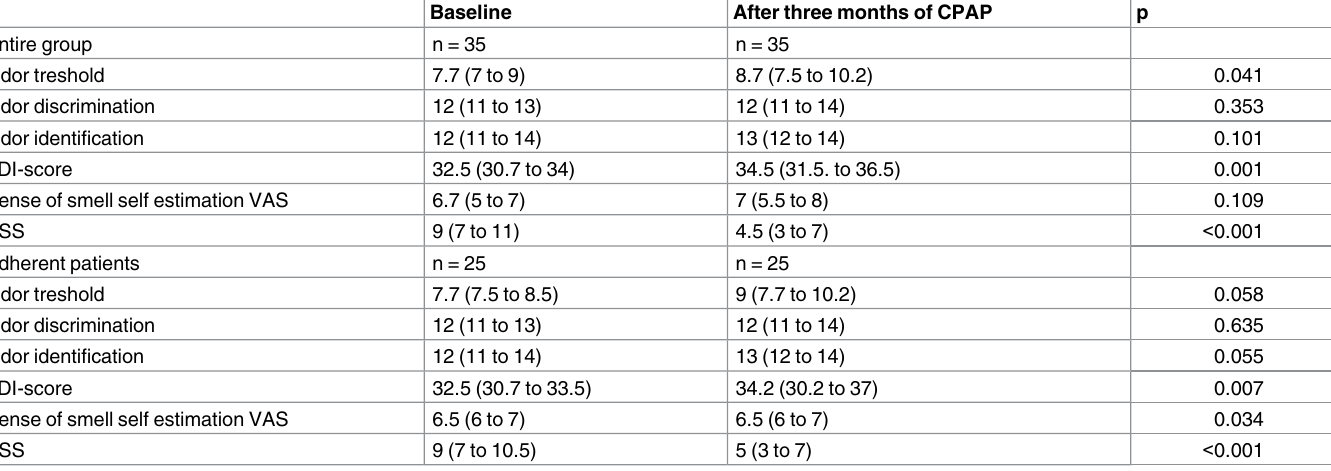
Table 3. Olfactory performance and sleepiness before and after nCPAP treatment of the entire group (n = 35) and of the 25 therapy adherent * sleep apnea